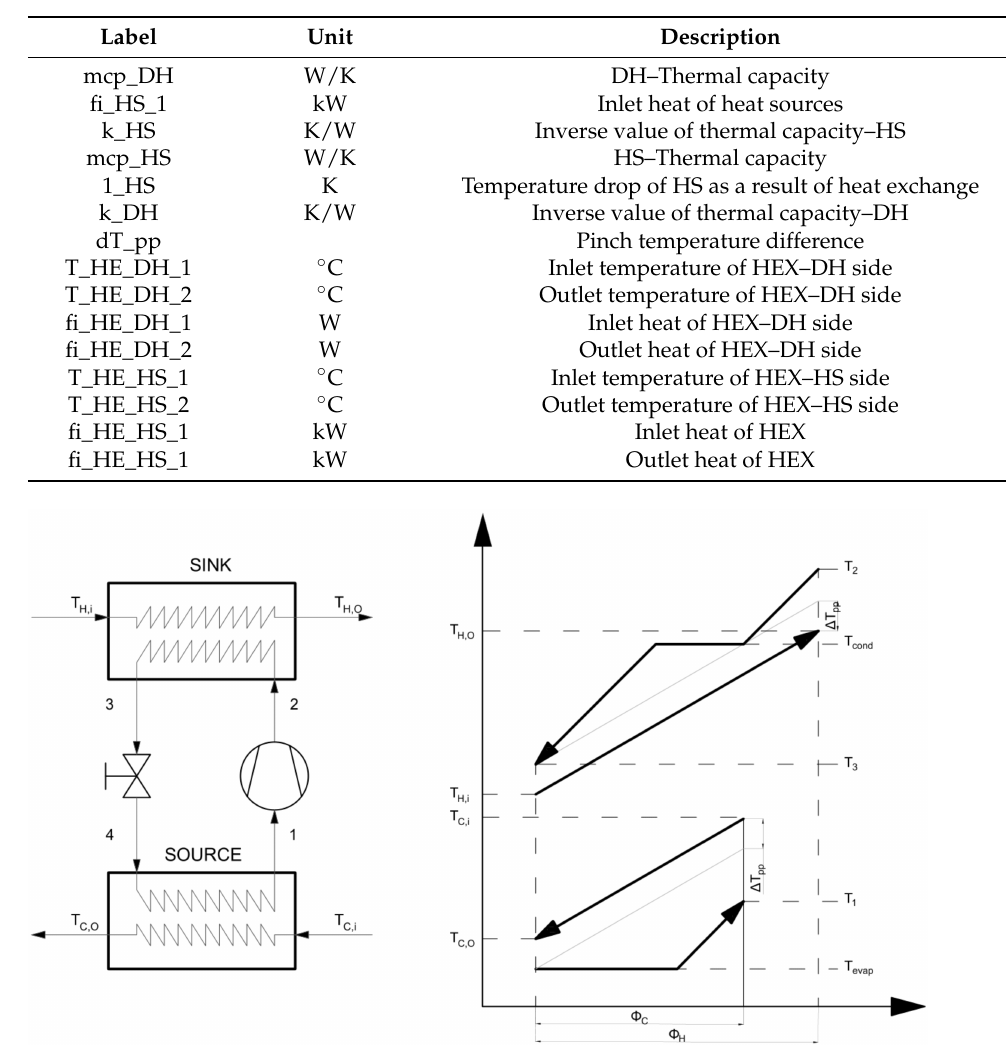
Figure 9. Booster heat pump scheme and overview of Lorenz efficiency